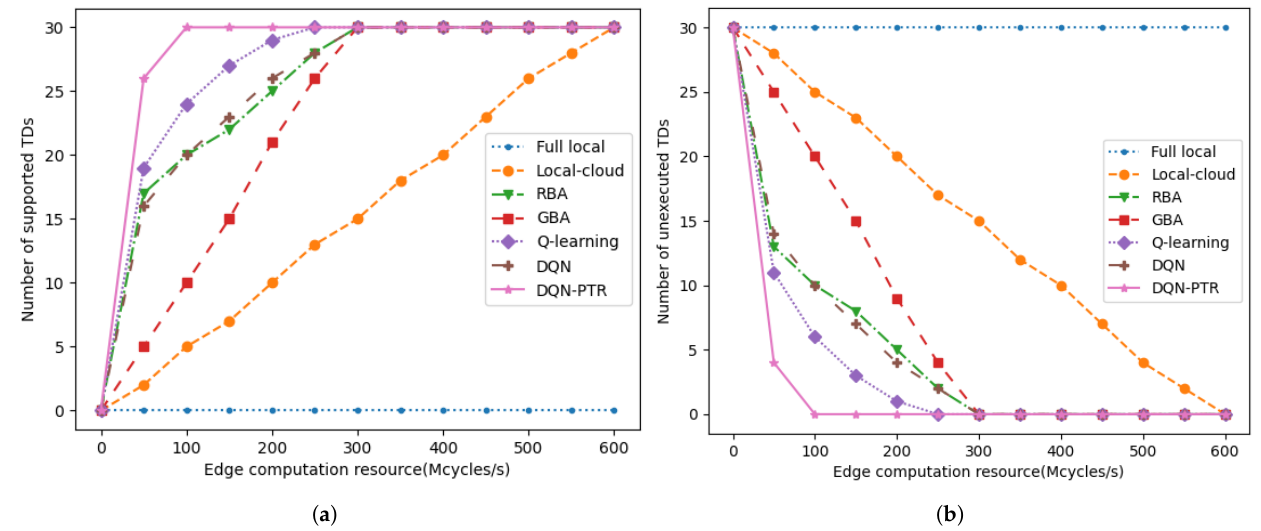
Figure 4. ( a ) The number of supported TDs versus the edge computation resource. ( b ) The number of unexecuted TDs versus the edge computation